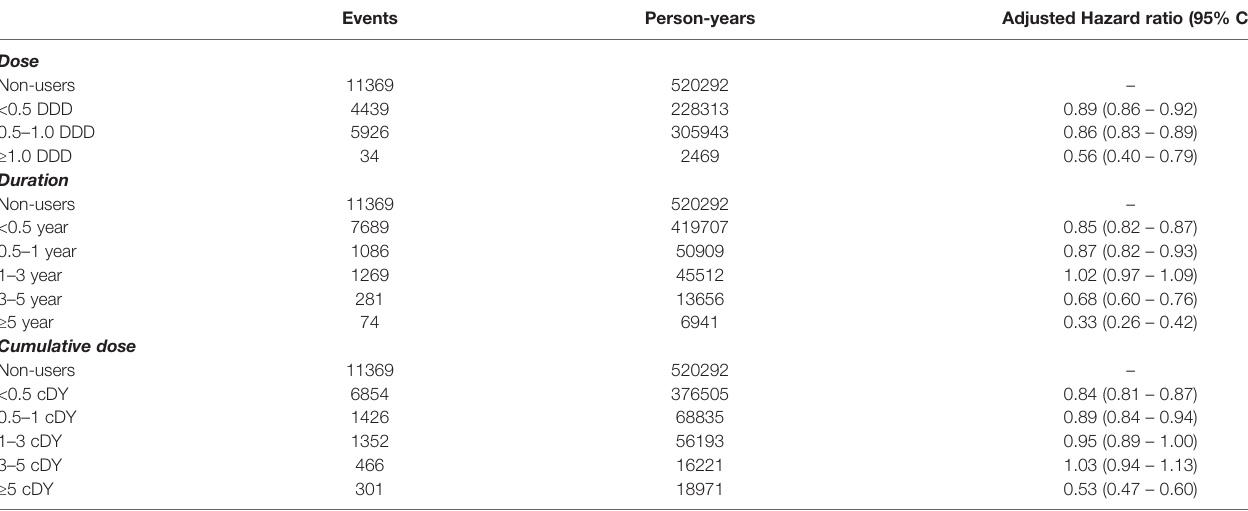
TABLE 3 | Hazard ratios for cancer according to dose, duration, and cumulative dose of cysteinyl leukotriene receptor